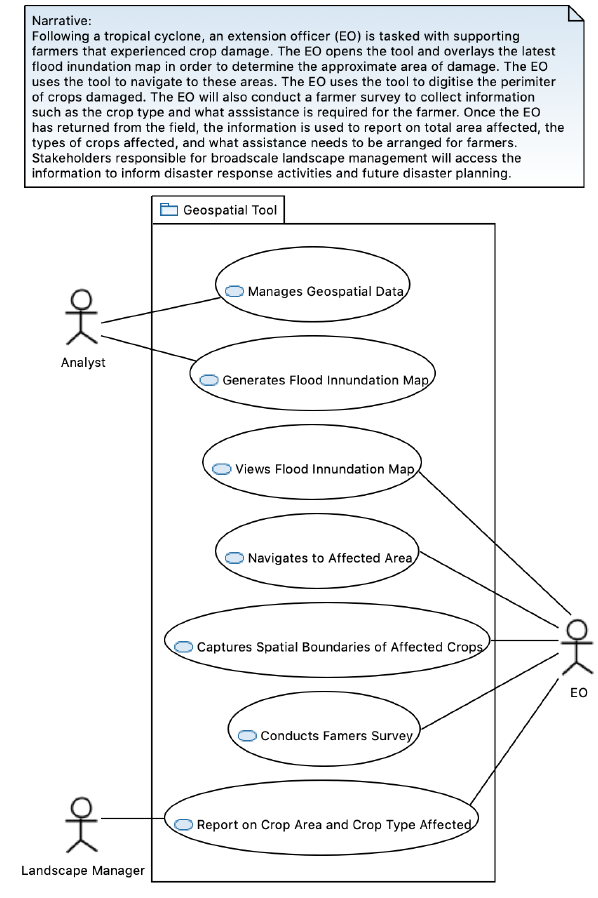
Figure 3. The narrative and diagram for the ‘survey crop damage after a tropical cyclone’ use case shows how ‘actors’ (an analyst, extension officer or EO, and landscape manager) would interact with the tool. .